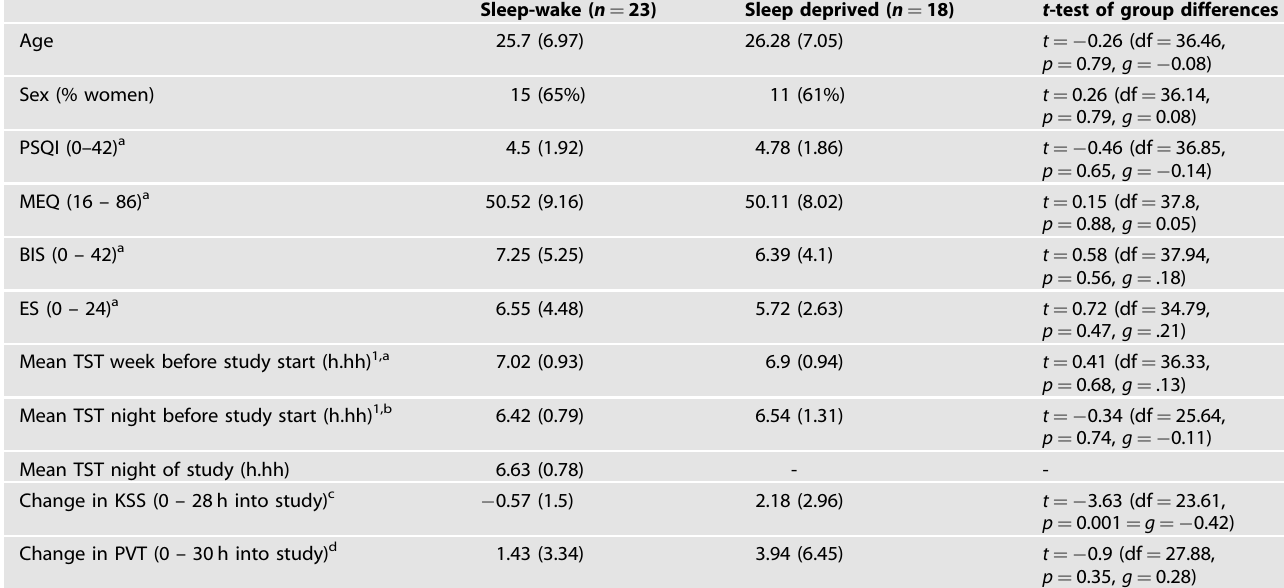
Table 1. Descriptive statistics for sleep-wake characteristics and tests of differences between sleep deprived and normal sleep-wake groups for each characteristic.